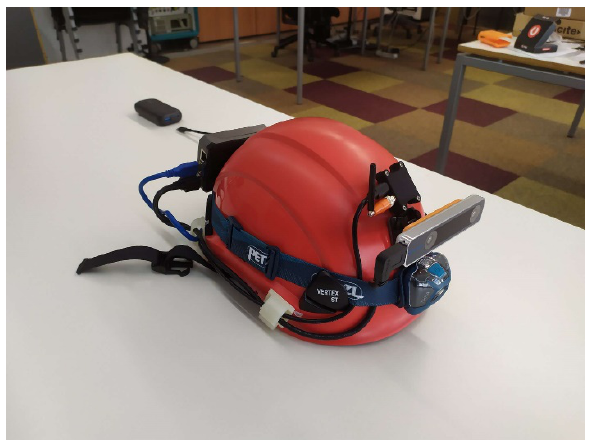
Figure 2 . IOPES positioning system mounted on a Helmet.